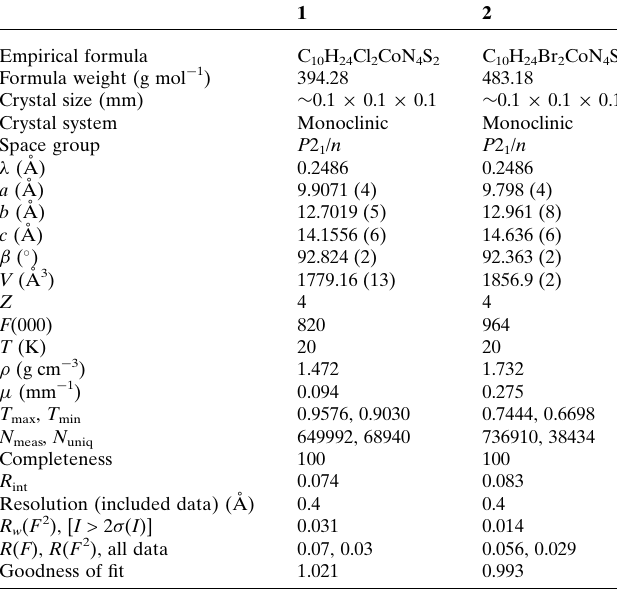
Table 1 Crystallographic details for the synchrotron data collections and refinements of 1 and 2 .